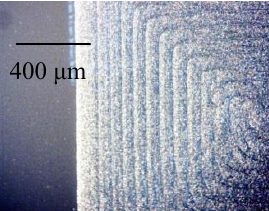
Fig. 7. Photo of film-polygon on scale of 45H .